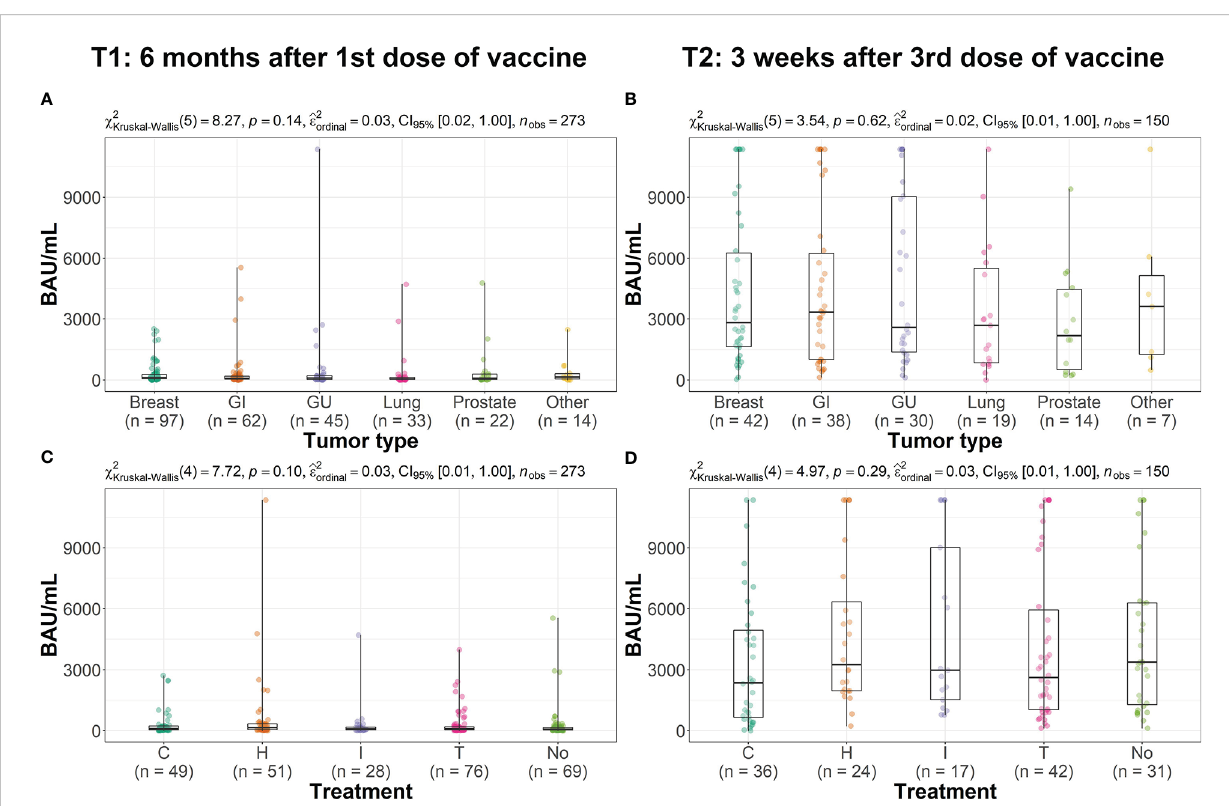
FIGURE 2 Distribution of the IgG-RBD-S value, expressed in BAU/mL, across groups. Box plots ( A – D ) refer respectively to T1 and T2. Each box covers the interquartile range; the splitting line is the median and whiskers represent minimum and maximum values. Statistical signi fi cance, set at p-value <0.05, was assessed using the Kruskal-Wallis test. (GI, Gastrointestinal; GU, Genitourinary; C, Chemotherapy; H, Hormone therapy; I, Immunotherapy; T, Target therapy; No, No treatment).